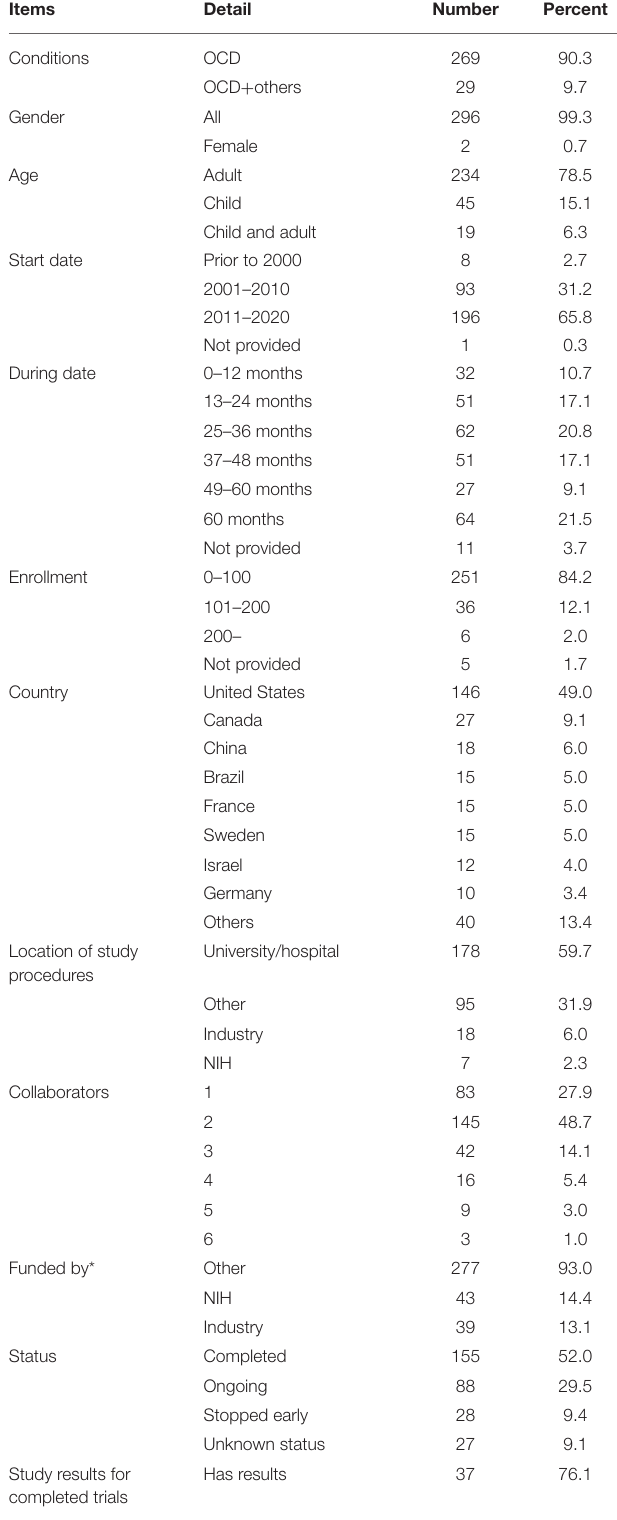
TABLE 1 | General characteristic of OCD trials registered in ClinicalTrials.gov ( n =